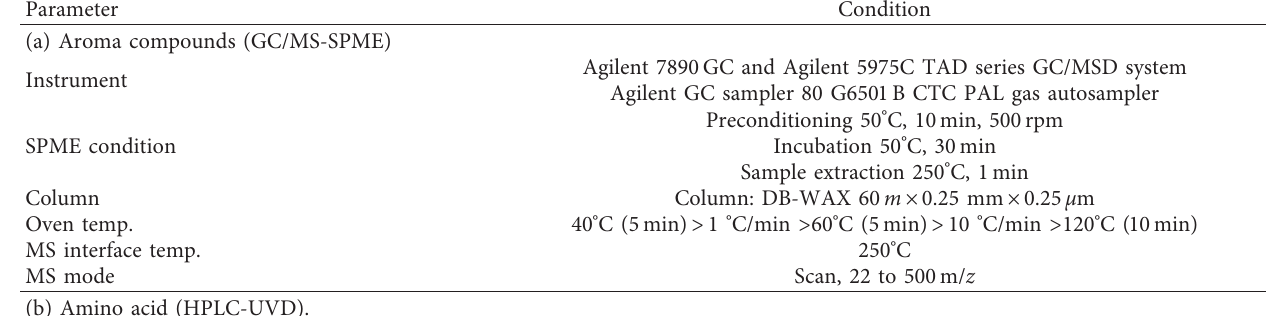
Table 1: Operating conditions for detection of the aroma and umami taste